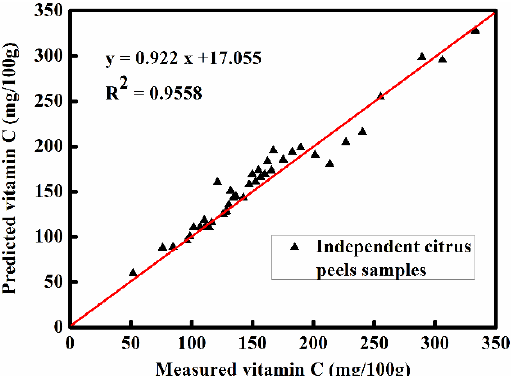
Figure 4. Predicted and measured values of vitamin C contents.